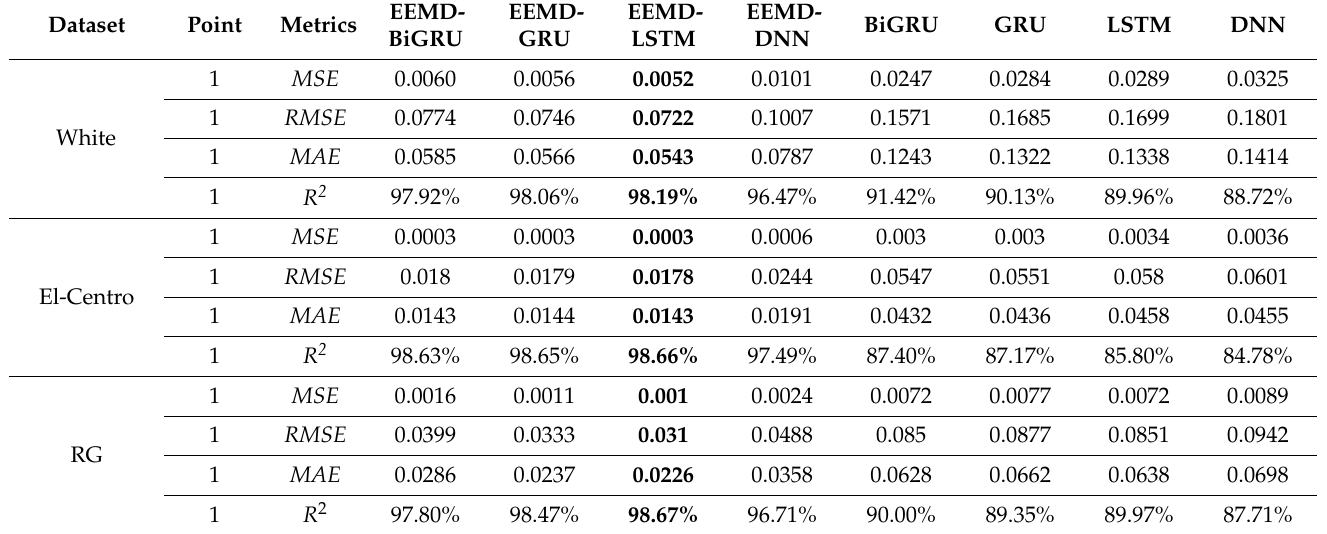
Table 2. Single-step